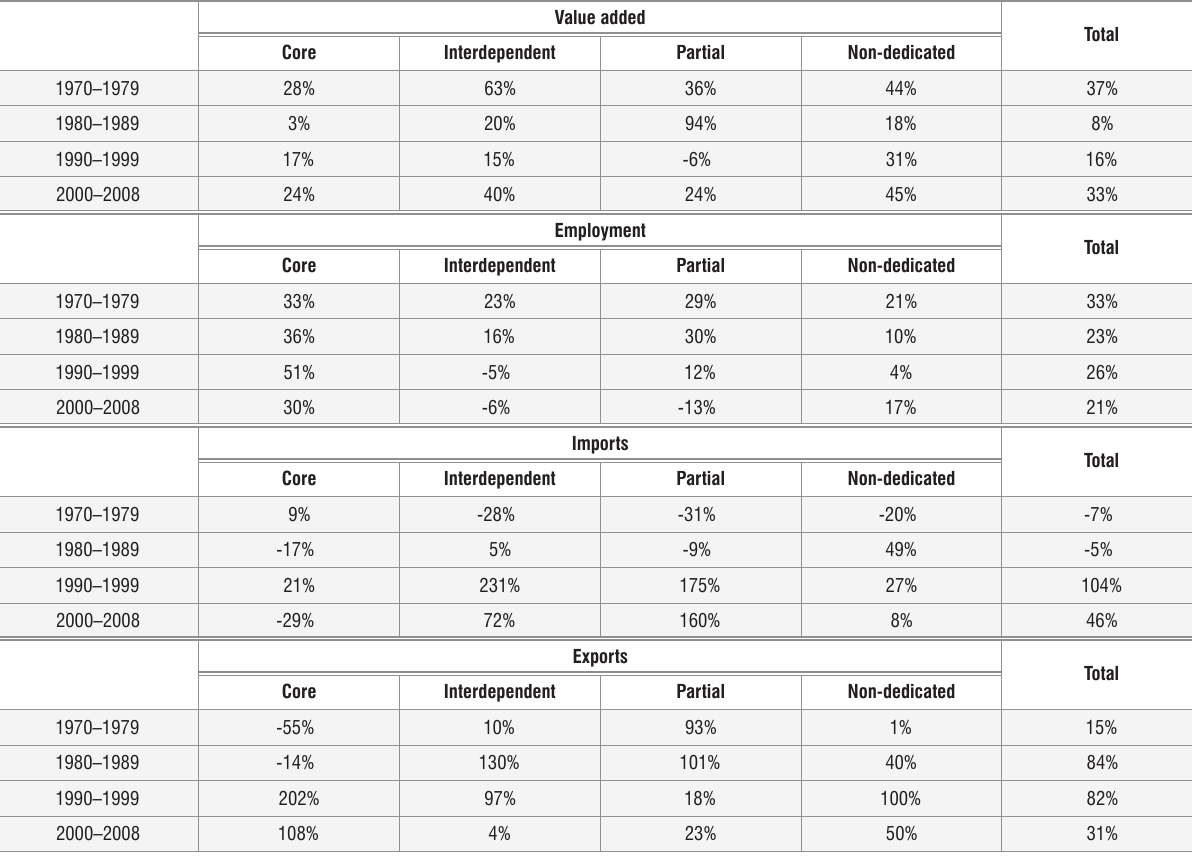
Copyright-based industries’ growth of share to the economy of value added, employment, imports and exports from 1970 to